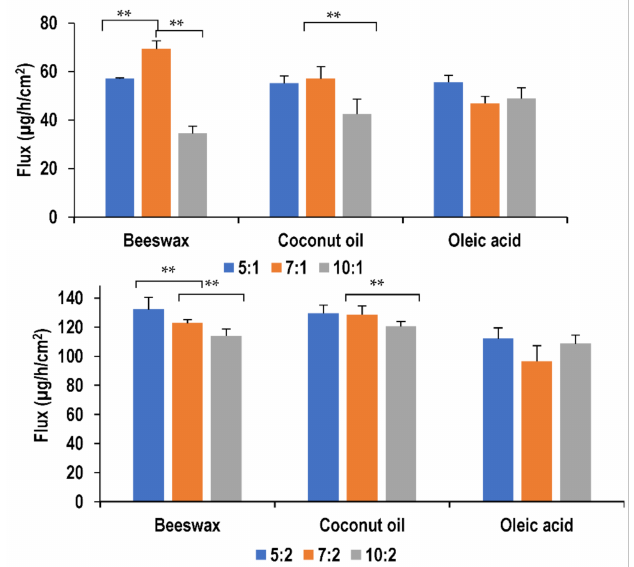
Figure 6. Effect of surfactant and oil concentration on flux of lidocaine nanoemulsion through PDMS membrane ( ** p >